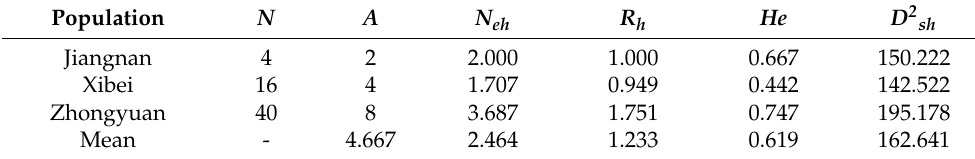
Table 3. Haplotype diversity in three tree peony populations based on 12 cpSSR markers. Population N